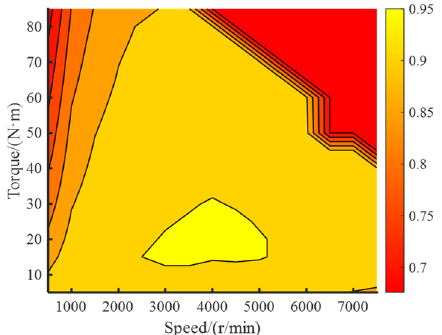
Figure 4. Efficiency map of the motor/inverter.